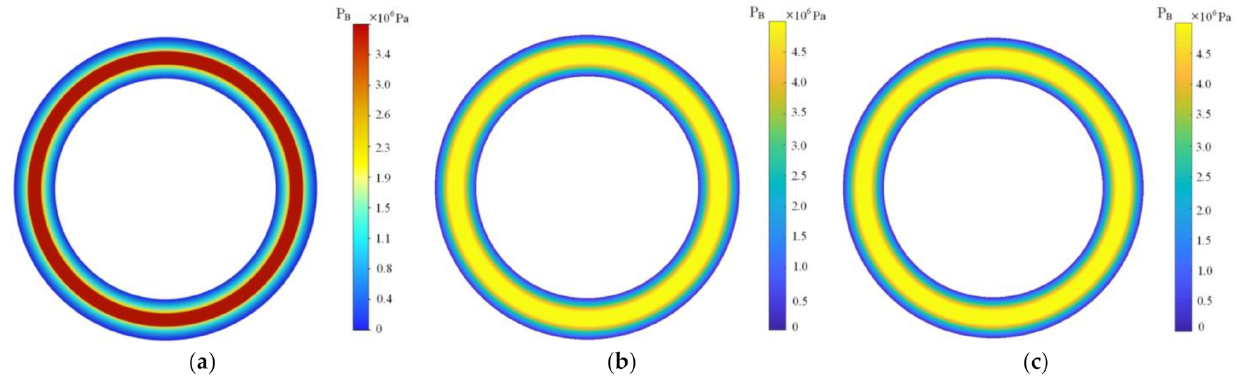
Figure 9. Pressure distributions obtained using Method “a” and